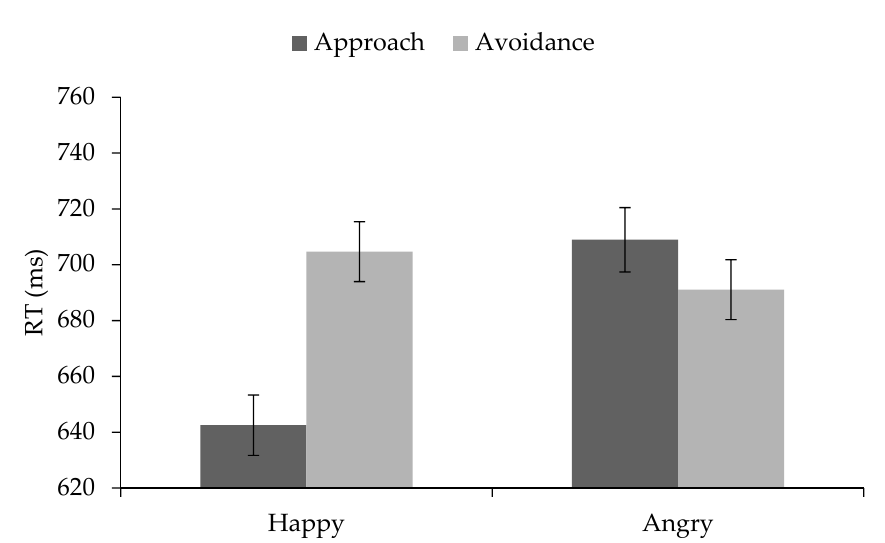
Figure 2. Mean reaction times (RTs) to happy and angry faces from Study 1. Error bars represent standard error of the mean.